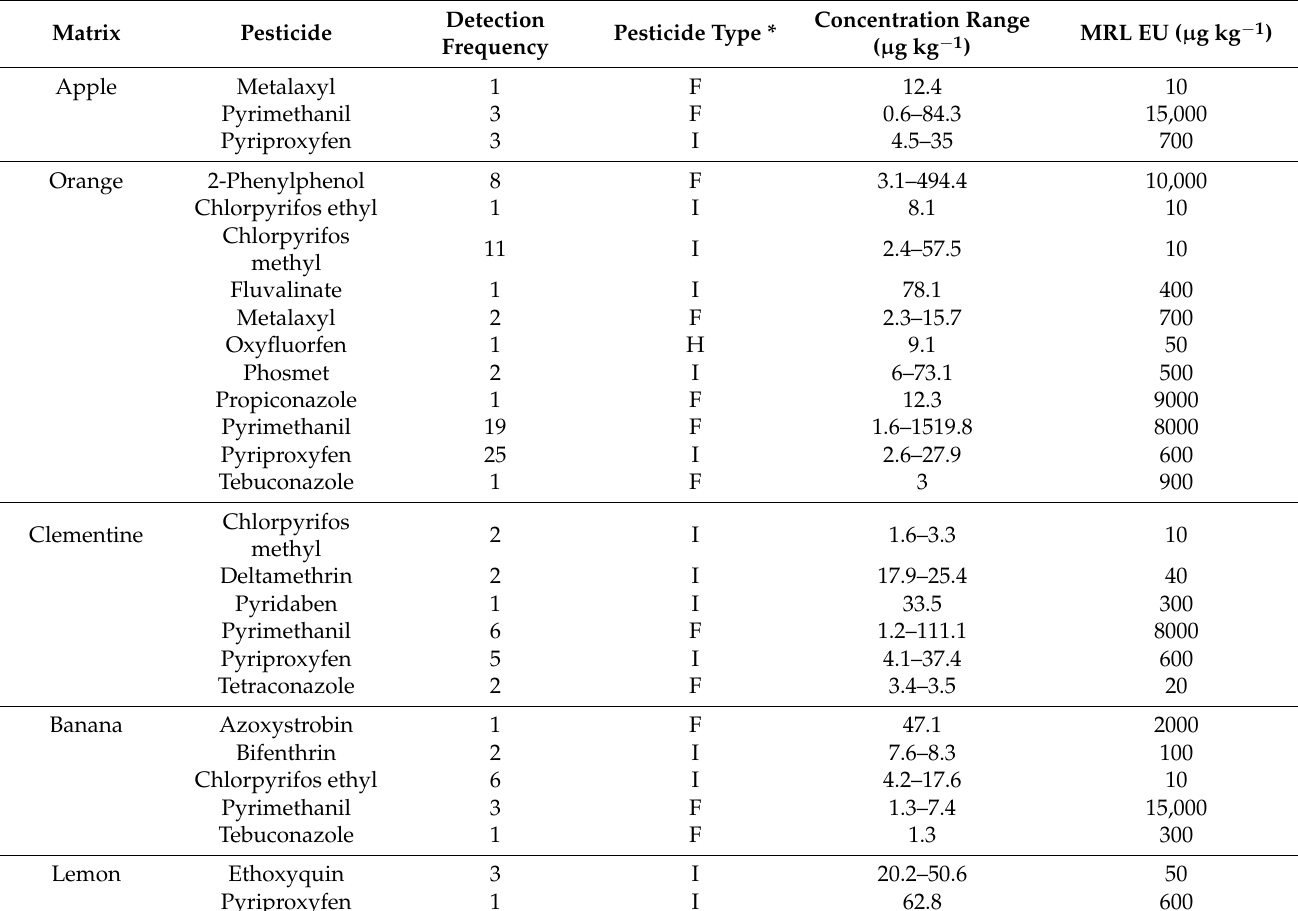
Table 1. Pesticide residues detected in fruit